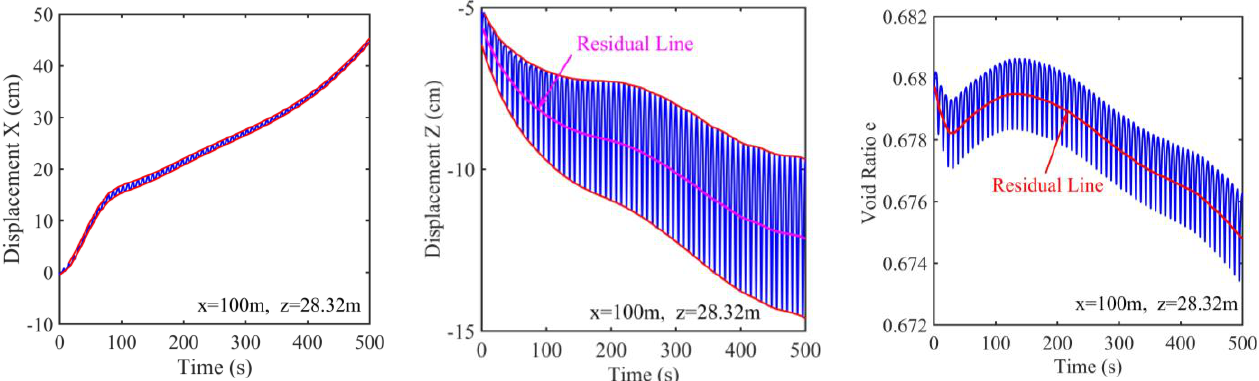
Figure 3. Time history of the displacement and void ratio of the seabed at x = 100 m, z = 28.32 m. It is shown that the loose seabed soil has a significant lateral spreading, as well as a vertical residual subsidence and an oscillatory vibration driven by the cnoidal wave (note: x = 100 m is the symmetrical line of the seabed floor).